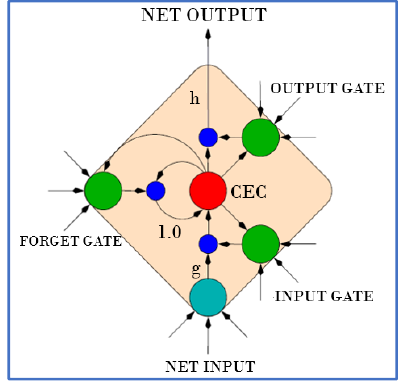
Figure 3. LSTM (Long Short-Term Memory Network) memory block.